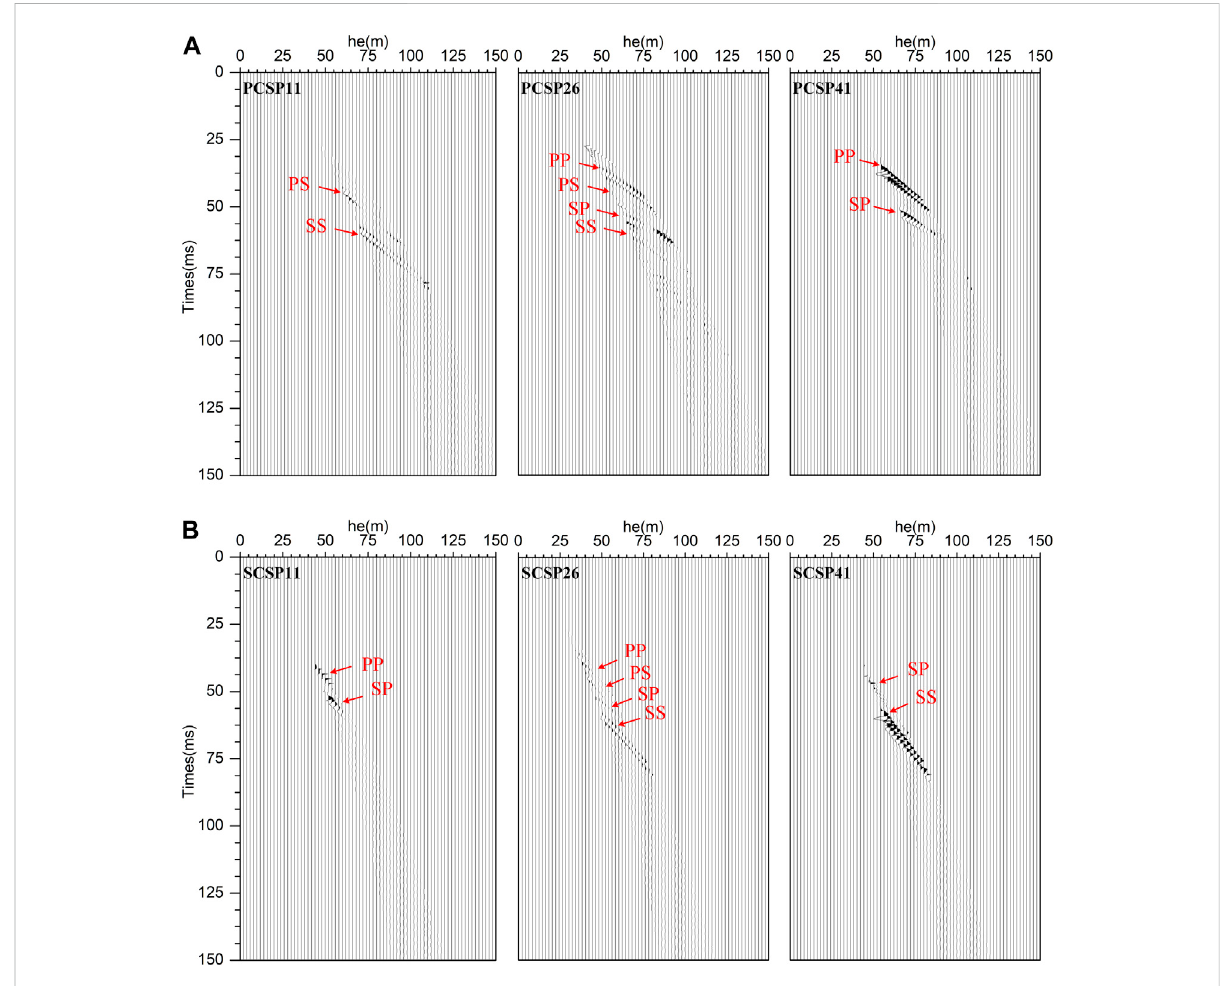
FIGURE 7 CSP gathers of the fault model. (A) P waves; (B) S waves.